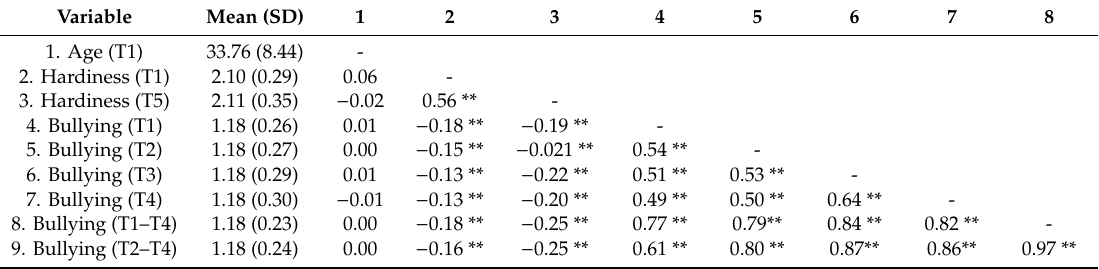
Table 1. Means, standard deviation (SD), and correlation between age, psychological hardiness, and exposure to bullying behaviors at the workplace.